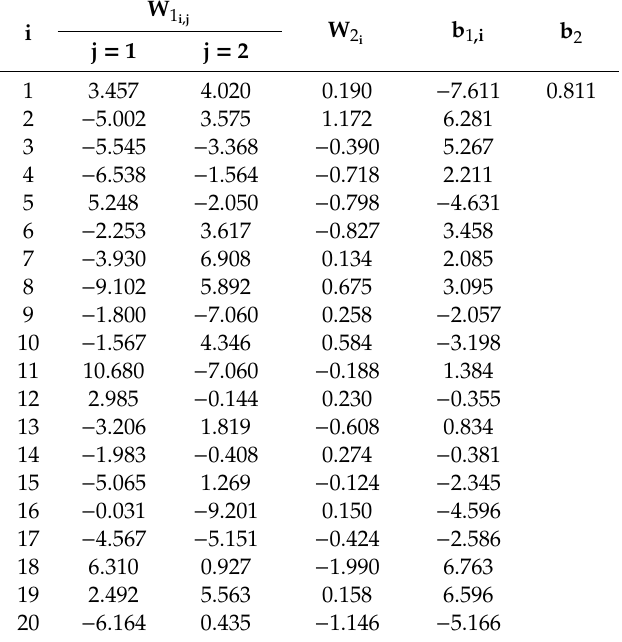
Table A2. Constants for estimating the normalized PV n in Equation (9).